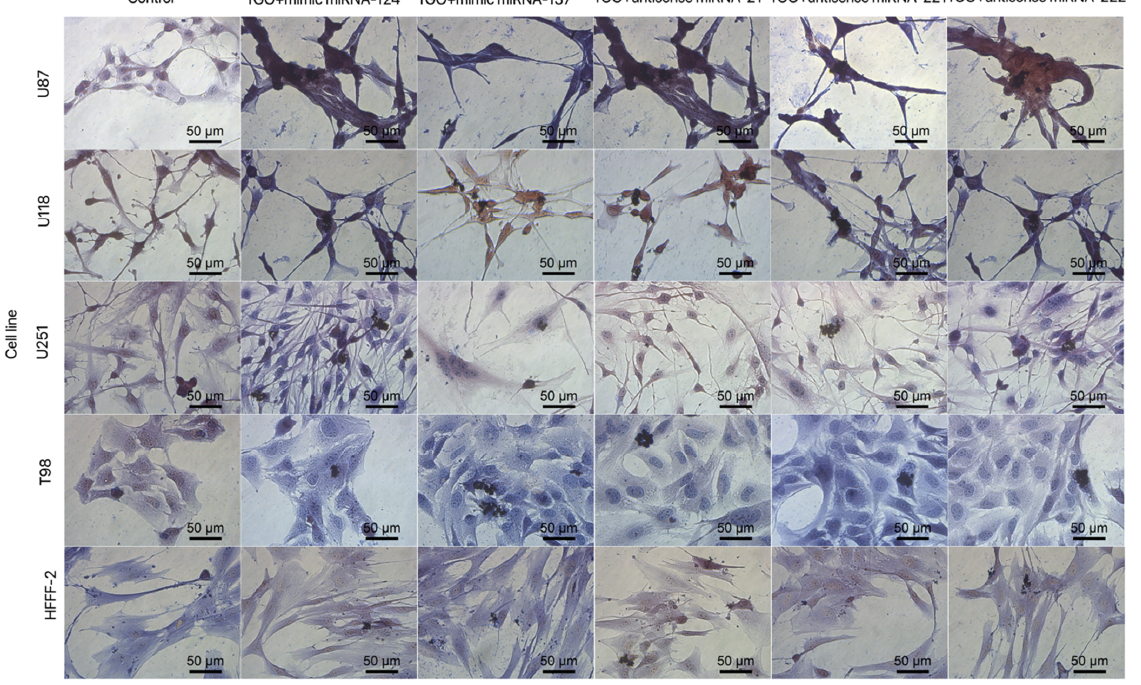
Figure 14. Morphology of U87, U118, U251 and T98 glioblastoma and HFFF-2 cells treated with rGO + mimic miRNA-124, rGO + mimic miRNA-137, rGO + antisense miRNA-21, rGO + antisense miRNA-221 and rGO + antisense miRNA-222. Light optical microscopy. Abbreviations: rGO: reduced graphene oxide. Scale bars: 50 µm.